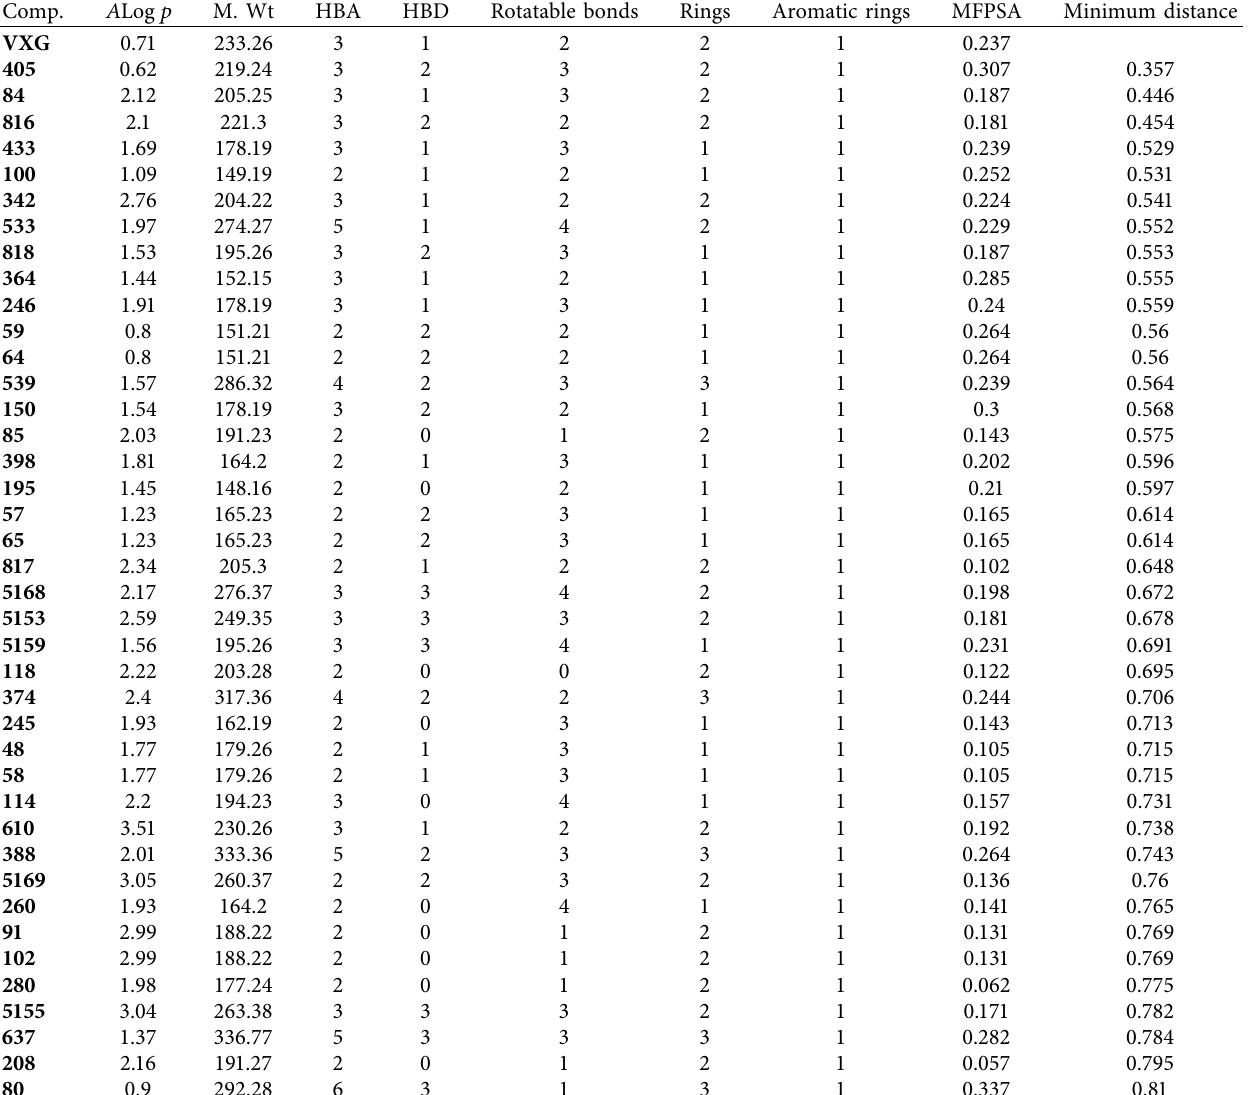
Table 2: Molecular descriptors of the examined 40 compounds and VXG .